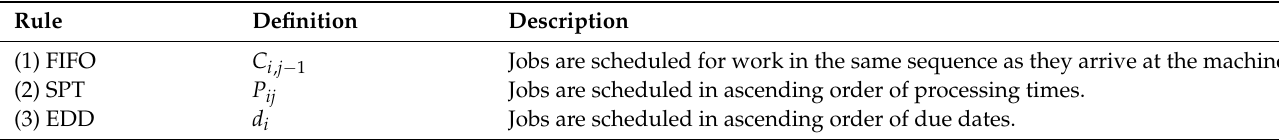
Table 2. Formalization for Dispatch Rule